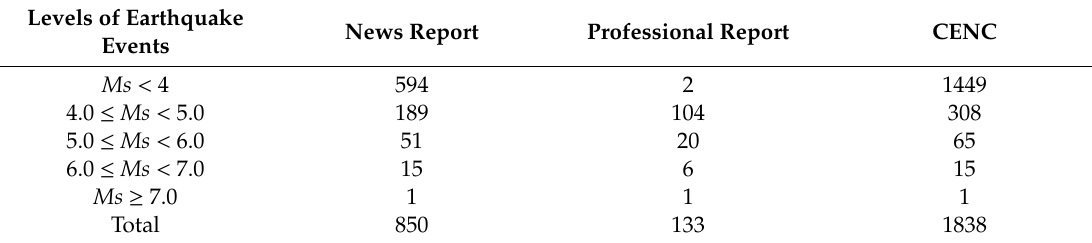
Table 5. Classification of earthquakes.